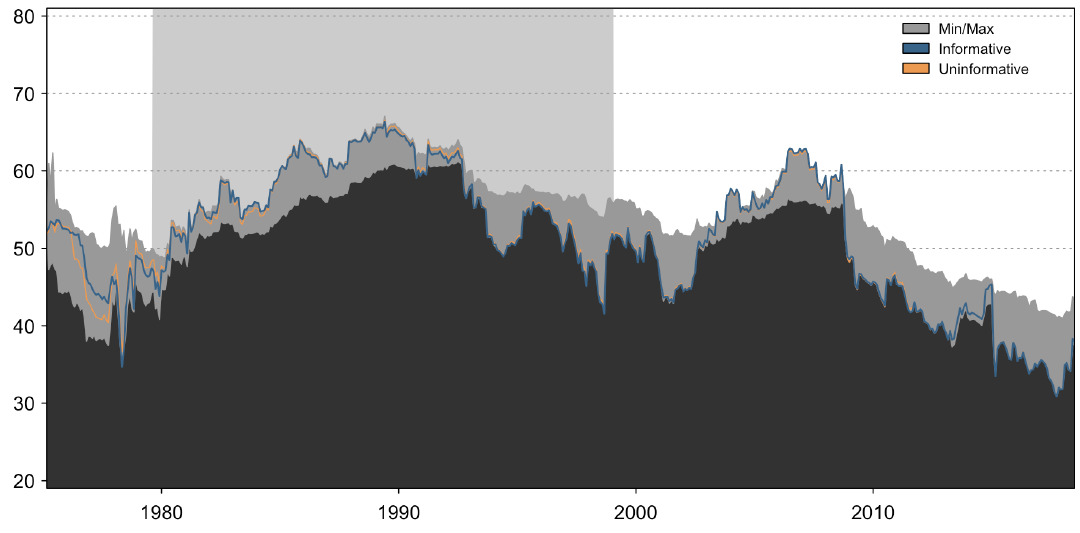
Figure 11. Dynamic total connectedness